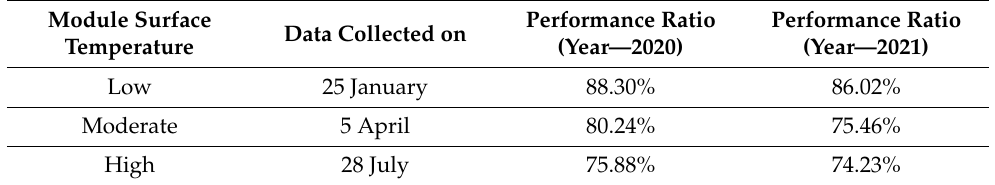
Table 4. Comparison of the performance ratio corresponding to different module surface temperatures over two years.